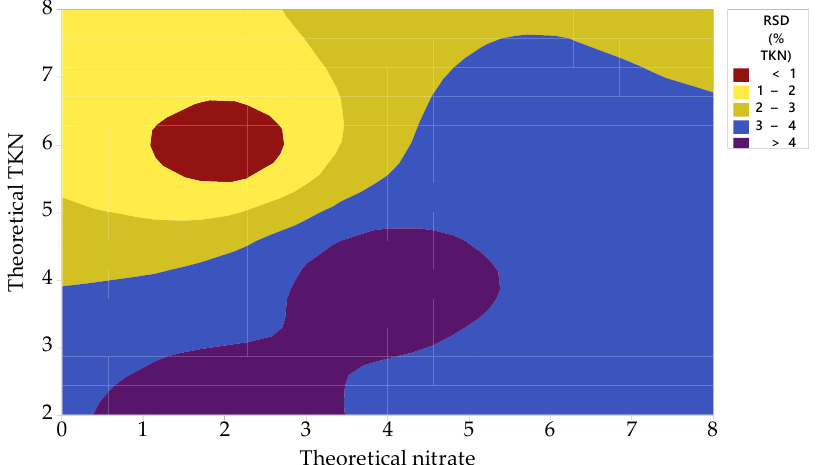
Figure 4. Contour plot for the error percentage in measured TKN concentrations obtained using the s-TKN TM method.